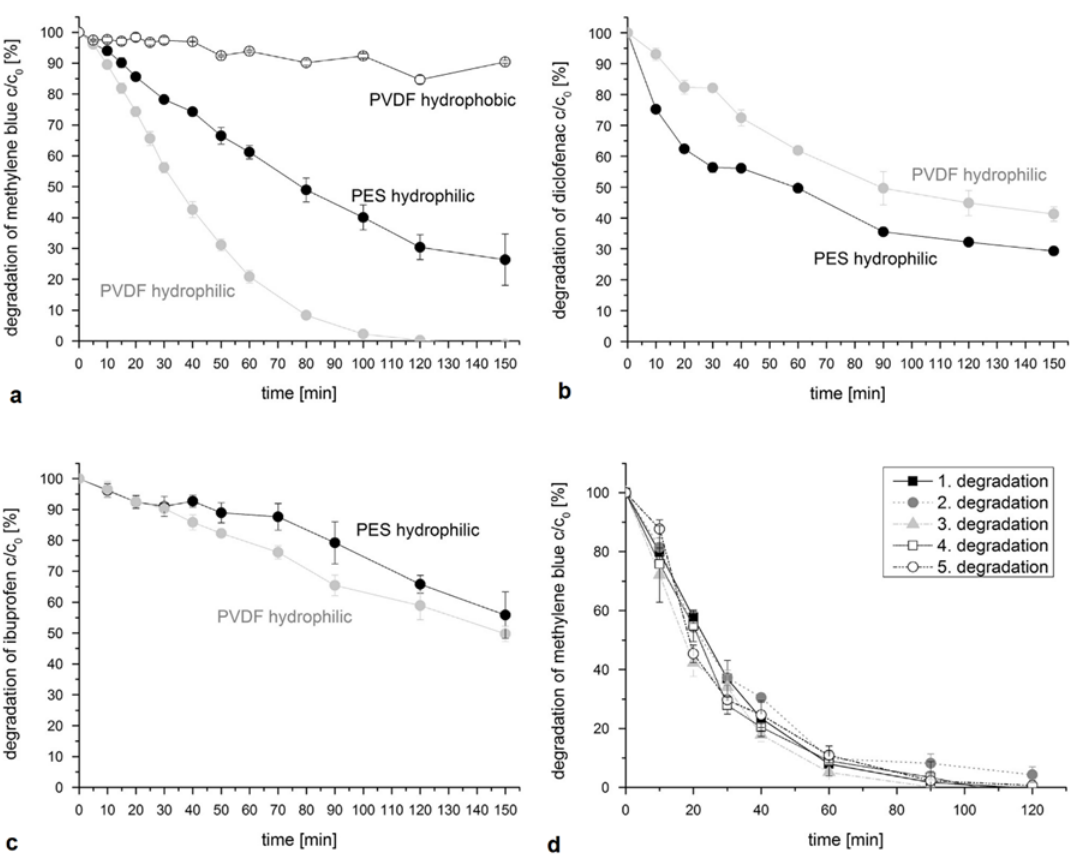
Figure 13. Pollutant photodegradation by hydrophilic PES membranes and hydrophobic PVDF membranes: ( a ) photodegradation of methylene blue; ( b ) photodegradation of diclofenac; ( c ) photodegradation of ibuprofen ( d ) photodegradation of methylene blue at different rates. Reproduced with permission from [63], Copyright 2015 Elselvier.